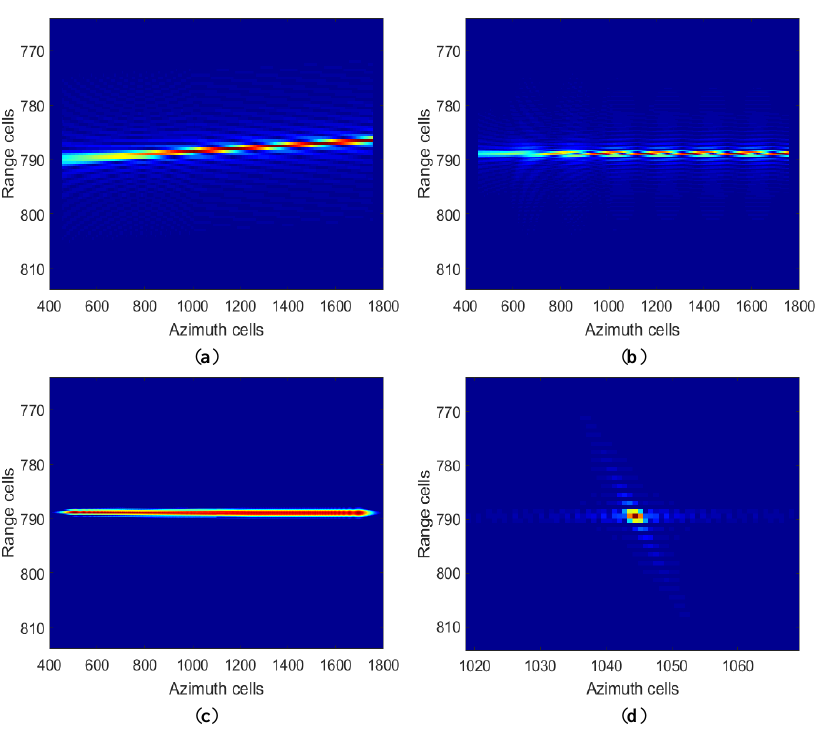
Figure 16. Accurate focusing procedures for the second GMT after clutter suppression. ( a ) The profiles in the 2-D time domain. The profiles after ( b ) decoupling, ( c ) accurate RWC, and ( d ) cu- bic RCMC.